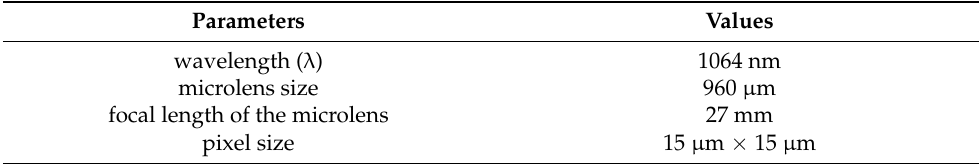
Table 1. Key parameters of the FBPM-SHWFS.